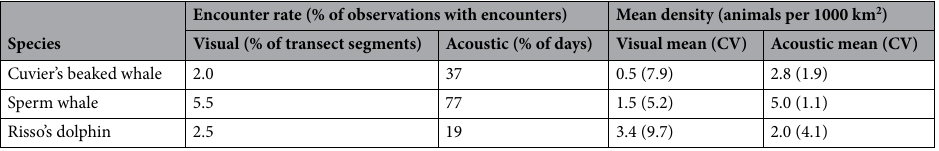
Table 2. Encounter rates and mean densities of each species within the visual survey and passive acoustic monitoring training datasets. Density estimates were calculated following Eqs. (2) and (3) for visual and passive acoustic methods respectively.